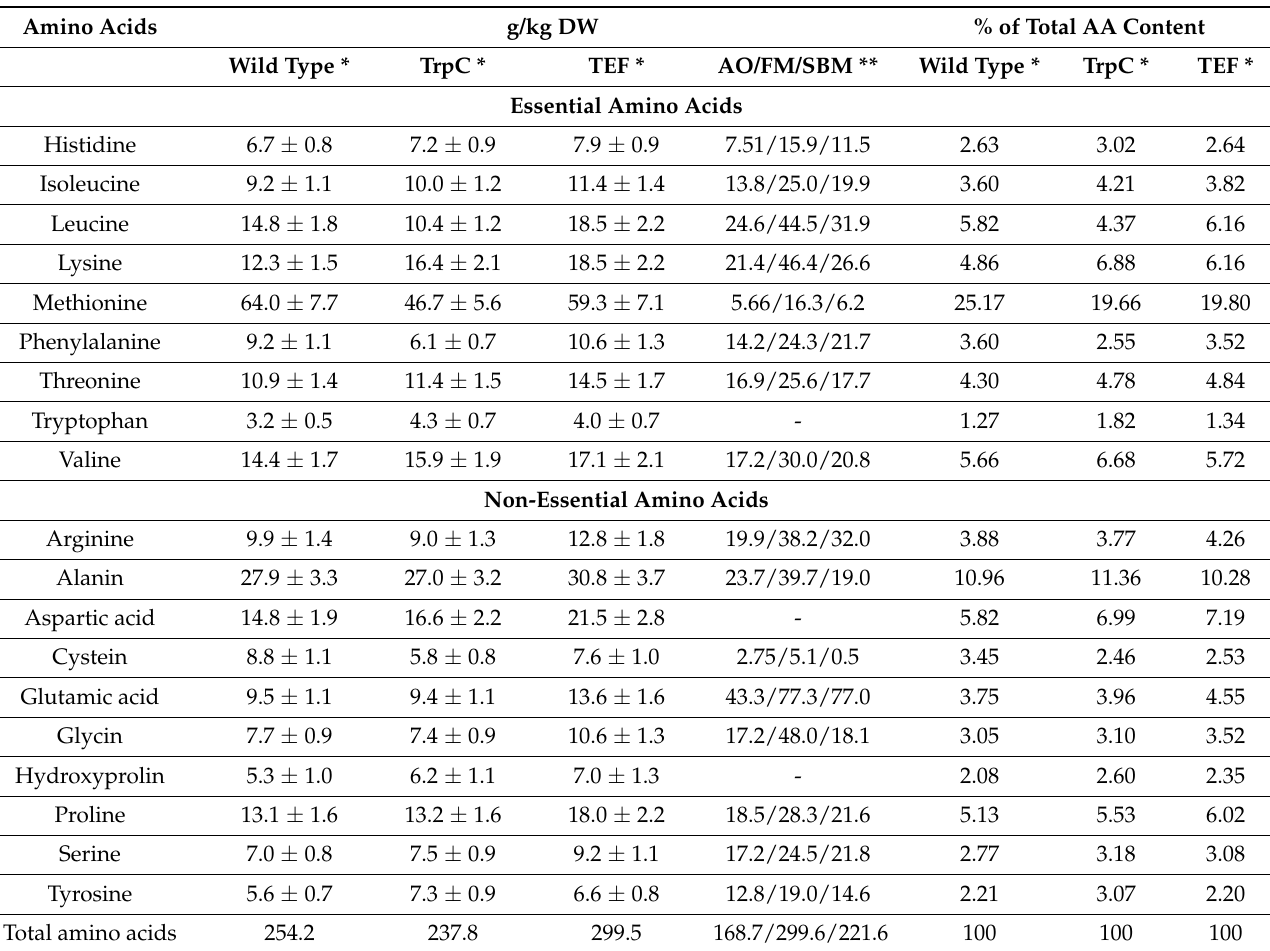
Table 1. Amino acid composition of the wild type and transgenic Th. thermophilus rF-859 clones TrpC and TEF (* this study, ** AO/FM/SBM— Aspergillus oryzae /Fishmeal/Soya bean meal data from the paper by Karimi et al.